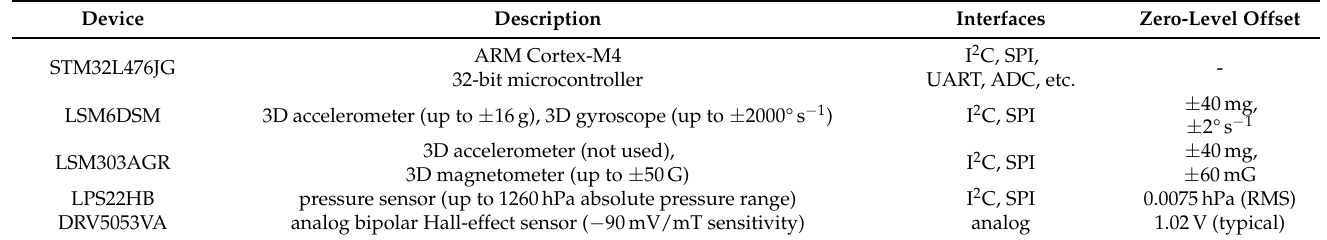
Table 1. IMU and sensors connected to the SensorTile module and their main characteristics.